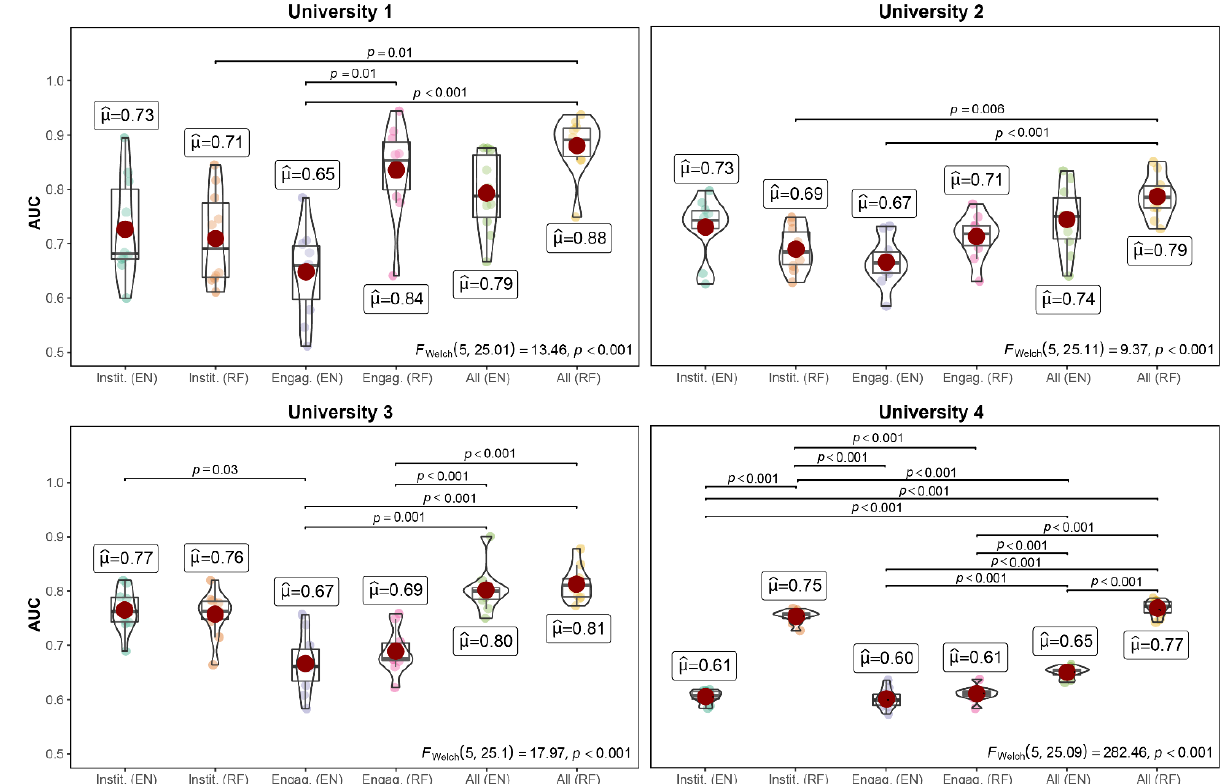
Figure 2. AUC performance across the four universities for different feature sets and models.